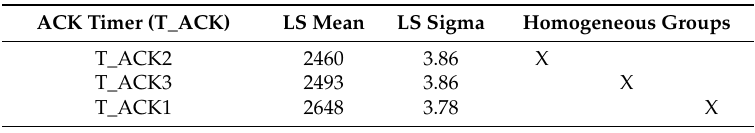
Limit to establish significant differences: